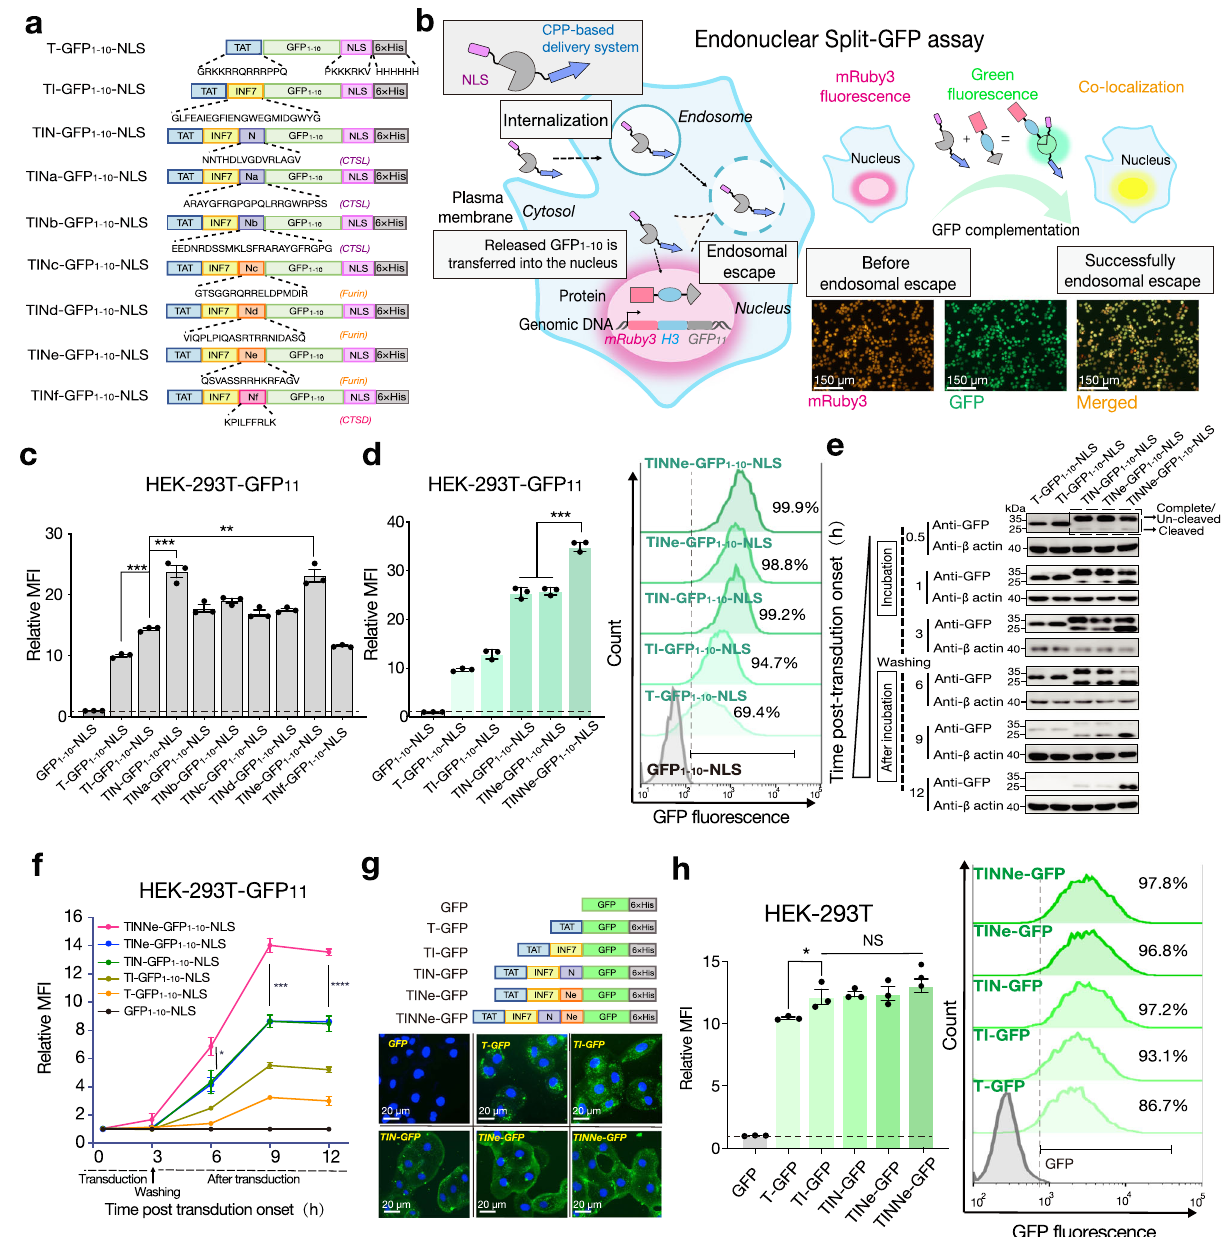
Fig. 1 Proteolytic removal of CPP-PMAP in endosomes enhances the escape ef fi ciency of protein cargos. a Schematic diagram of different GFP 1 – 10 -NLS- related recombinant proteins. The amino acid sequences of TAT, INF7, NLS, 6 × His and the different proteolytic cleavage sites (N and Na-Nf) are presented below, and each protease-recognised cleavage site is labelled in brackets. b Schematics of the endonuclear split GFP assay. Only after GFP 1 – 10 - NLS was released from the endosome and translocated into the nucleus of HEK-293T cells with stable expression of histone H3-GFP β -sheet 11 (HEK-293T GFP 11 ), the fl uorescence of the complete GFP in the nucleus observed, and co-localised with the mRuby3 fl uorescence. c The MFI of HEK-293T GFP 11 cells treated with GFP 1 – 10 -NLS-related proteins containing different cleavage sites (5 μ M). d The MFI (left panel) within total HEK-293T cells and the corresponding percentage of green fl uorescence-positive cells (right panel) treated with GFP 1 – 10 -NLS-related proteins containing two cleavage sites (5 μ M). e Immunoblot analysis of GFP and f the MFI in the treated cells at different time points during the endonuclear split GFP assay (1 μ M). g Representative microscopy images of cytosolic fl uorescence distribution in MA-104 cells treated with different GFP-related proteins (1 μ M) as indicated (upper panel: scheme diagram of GFP-related constructs). h The MFI (left panel) within total HEK-293T cells and the corresponding percentage of green fl uorescence-positive cells (right panel) after treatment with GFP-related proteins (1 μ M). For ( c , d , f , and h ) the results shown are the means ± s.e.m.; n = 3 biologically independent samples; * P < 0.05, ** P < 0.01, *** P < 0.001, and NS no signi fi cant difference; two-tailed unpaired student ’ s t test. Relative MFI (fold increase) was obtained by MFI of total cells treated with the indicated proteins divided by that of total cells treated with the corresponding cargo protein only. For ( b bottom panel) and ( g bottom panel), the data shown are representative of three independent experiments, respectively; for ( e ), the data shown are representative of two independent experiments. For data, statistics, exact P values and uncropped images of the immunoblots, see Source Data File.